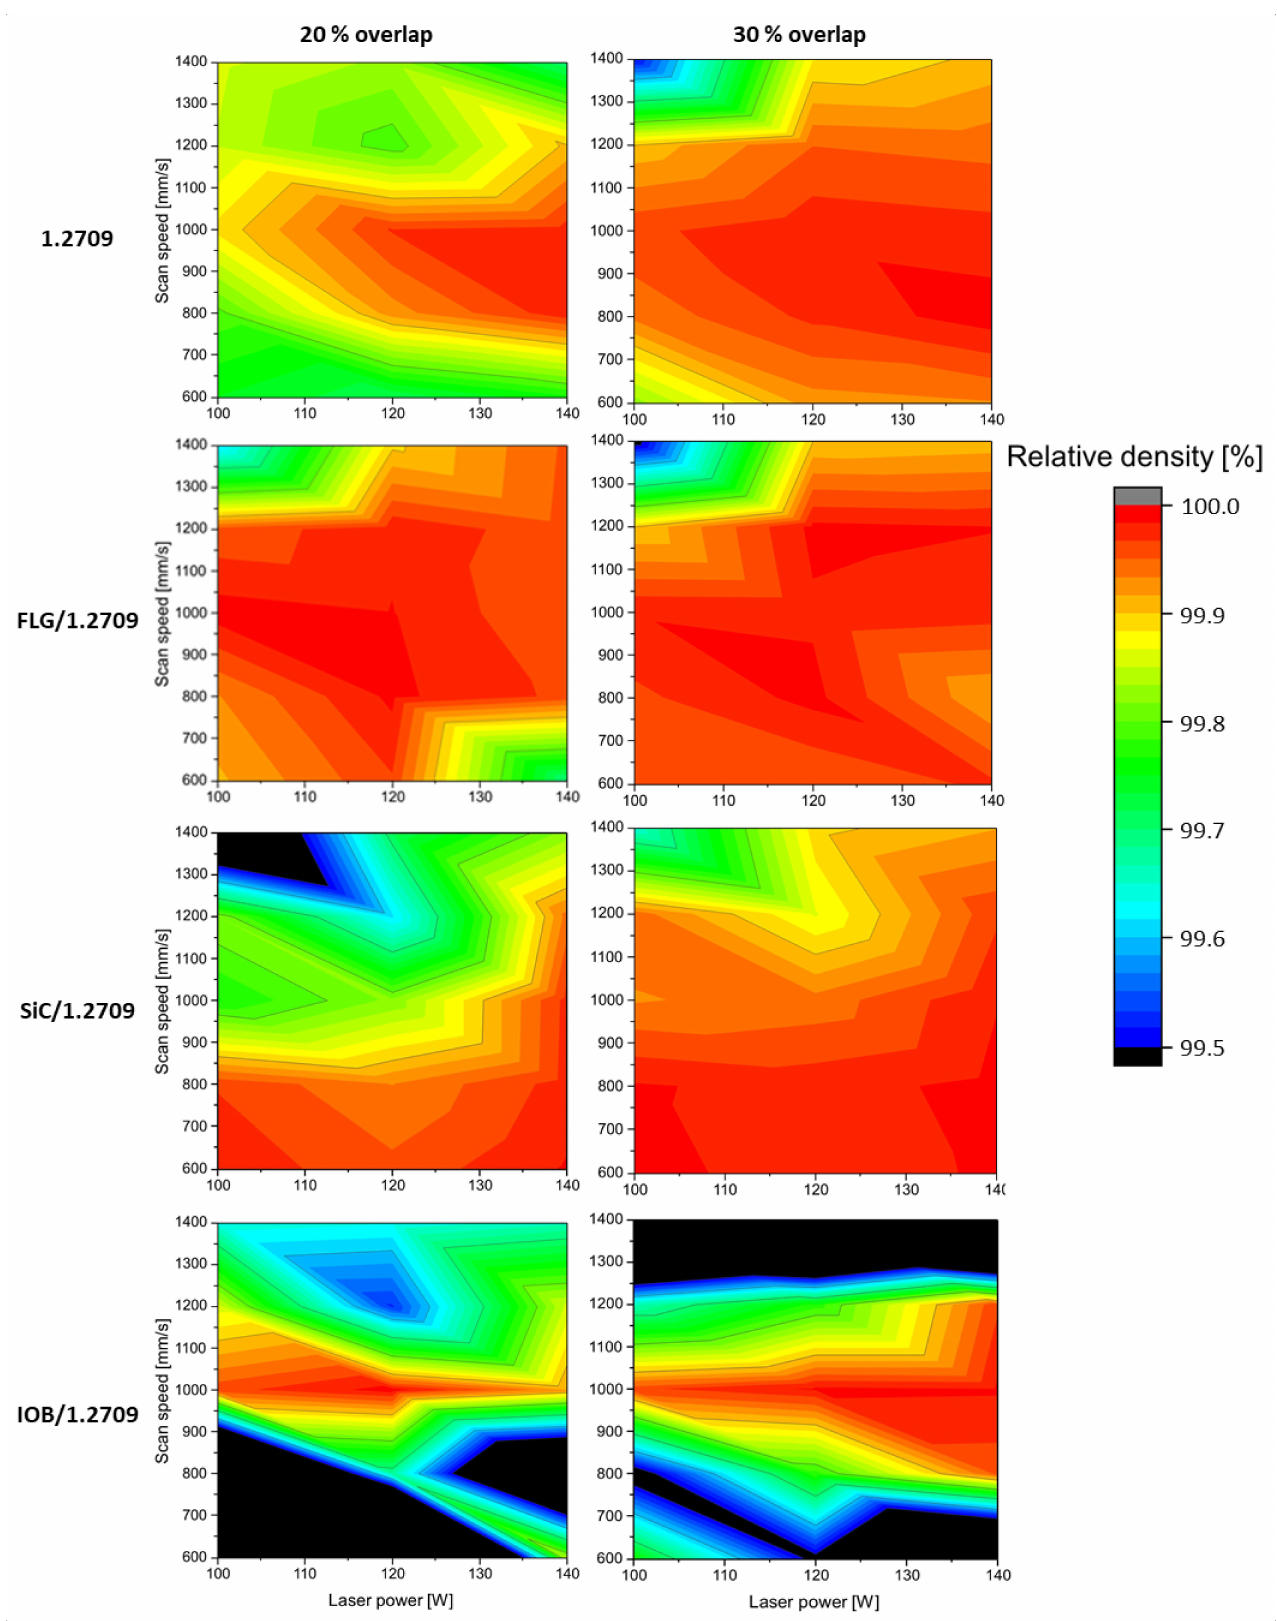
Figure 10. Relative densities of 1.2709, SiC/1.2709, FLG/1.2709, and IOB/1.2709 using different overlaps for adjacent welding lines of 20% and